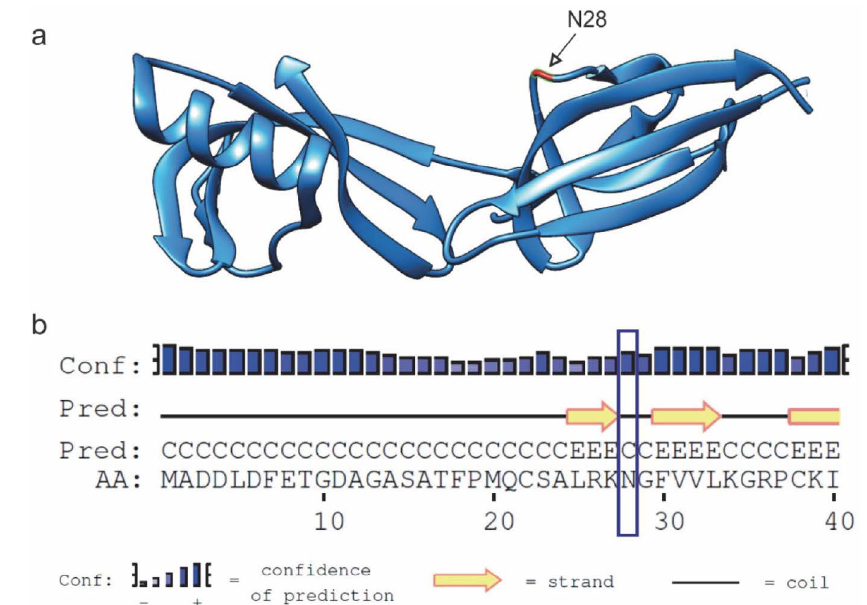
Figure 3. Example of a legumain cleavage site in a 3D protein structure. (a) The structure of eukaryotic translation initiation factor 5A-1 with anno- tated scissile site at asparagine 28 (For preparing this image the structure with PDB 3CPF was used). (b) An example of secondary structure predic- tion algorithm output for the region around Asn28 in eukaryotic translation initiation factor 5A-1 (marked in